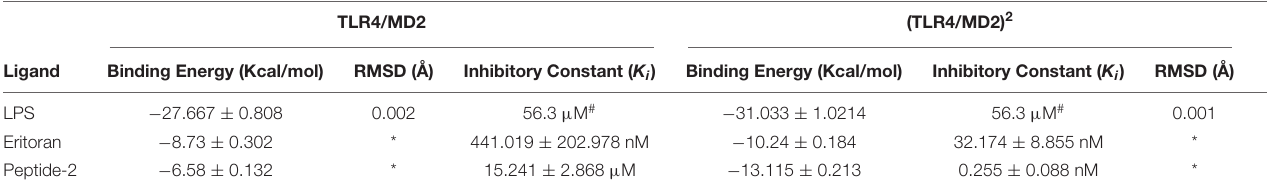
TABLE 1 | Theoretical free binding energy for the docking calculations of ligands with the murine TLR4/MD2 complex (PDB ID = 3VQ2) obtained with AutoDock Vina 1.1.2 and theoretical inhibition constant ( K i ) obtained with the method from Wermuth (79).